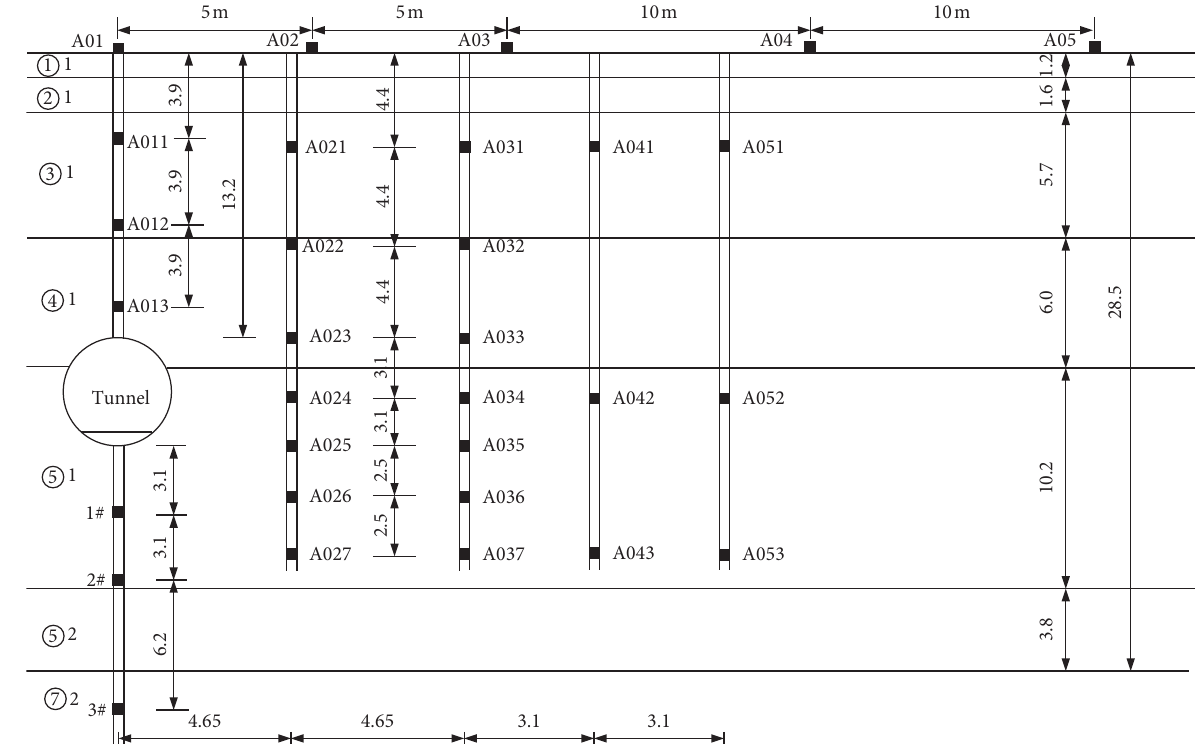
Figure 6: Diagram of measurement points in the ground and on the ground surface.